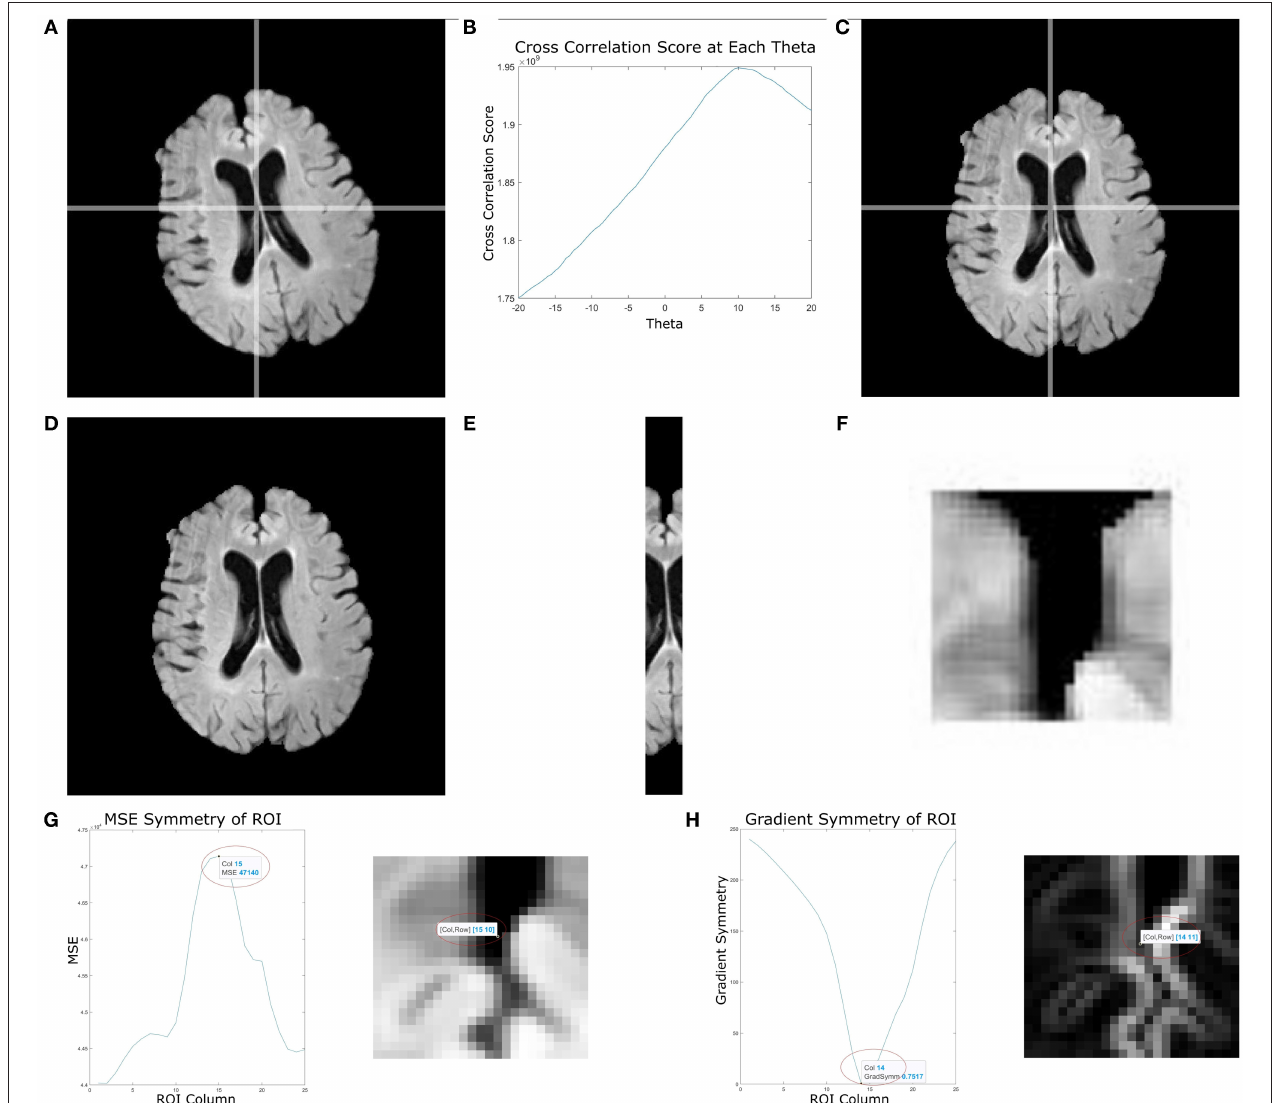
FIGURE 2 | This figure depicts multiple stages of the proposed midline estimation. (A–C) Head angle correction step where (A) is the original image, (B) is the cross correlation values for each θ , and (C) the image with corrected head angle. (D–F) ROI extraction where (D) is the pre-processed image, (E) is the ROI 2 cm around the middle column, (F) is the 2 by 2 cm window starting from the first non-zero row. Lastly, (G,H) show symmetry feature optimization, where (G) is the mean squared error symmetry and (H) is for gradient-based symmetry.